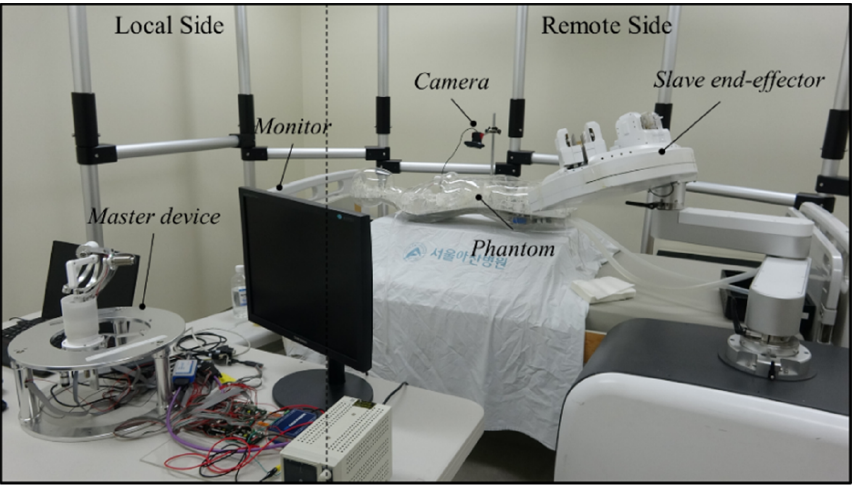
Figure 12. P hantom experimental setup for percutaneous coronary intervention procedure. Figure 12. Phantom experimental setup for percutaneous coronary intervention